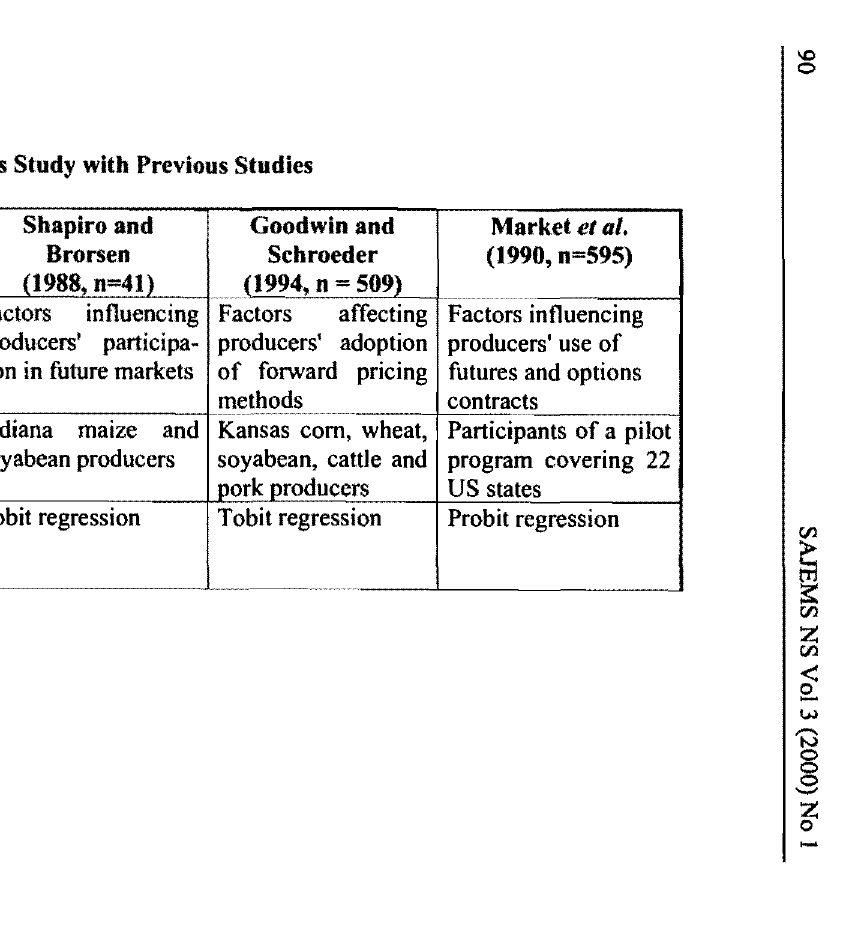
Table 2 Comparison of Results of this Study with Previous Studies